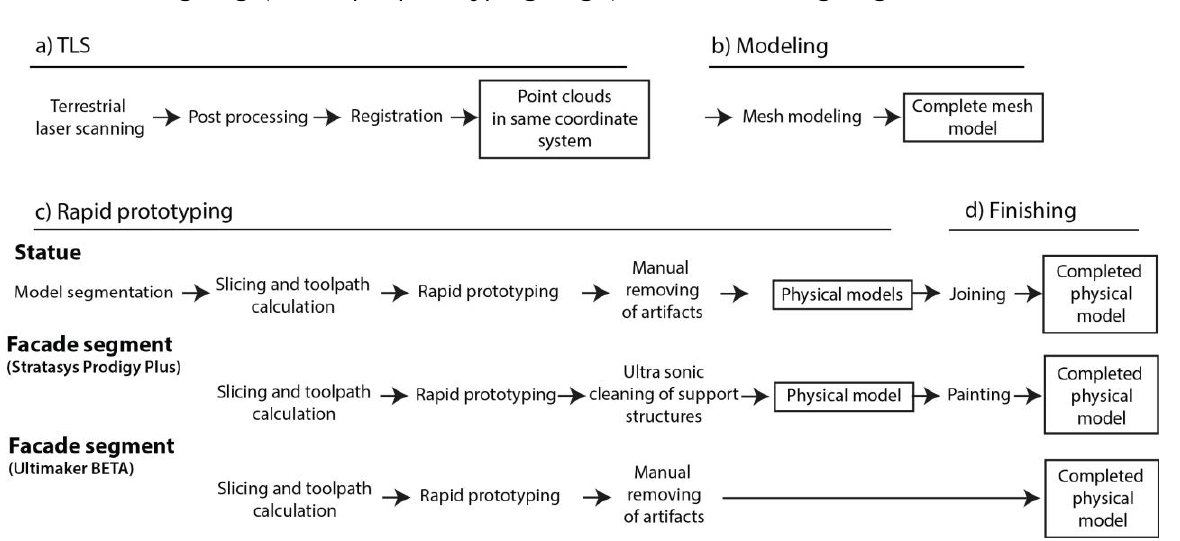
Figure 10. Comparison of rapid prototyping processes at different stages: ( a ) TLS stage; ( b ) Modeling stage; ( c ) Rapid prototyping stage; and ( d ) Finishing stage.